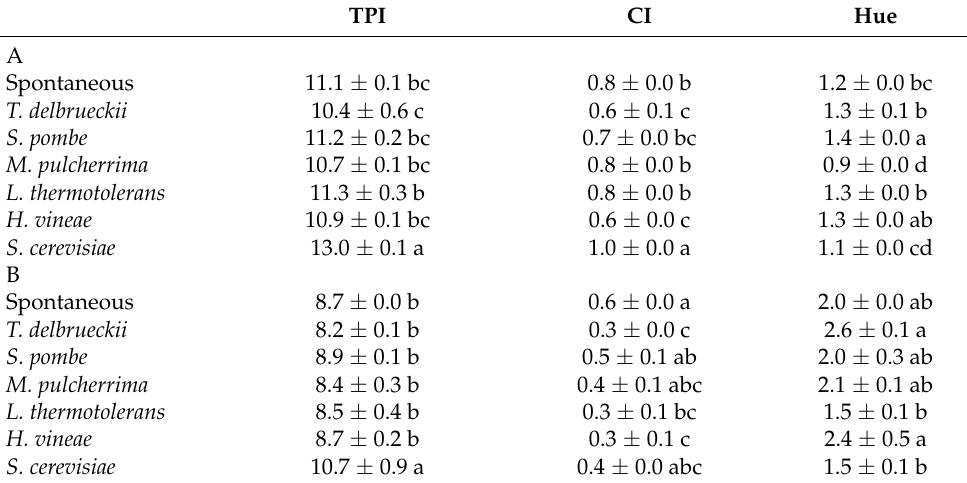
Table 4. Total polyphenolic index (TPI), colour intensity (CI) and hue for wines produced from (A) control fermentations and (B) PL treatment. Average and STD for n = 3. Different letters indicate significant differences within the same treatment.